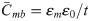
Electrophysiological changes in cellular physiology occur with increasing malignancy.A: The specific capacitance of the cell membrane (C¯mb=εmε0/t) increases with malignancy in the MOSE cell line, from the MOSE-E (n = 14), MOSE-L (n = 15), and MOSE-LTICν (n = 13). B: The specific conductance of the cell membrane (G¯mb=σmb/t) and C: the cytoplasmic conductivity (σcp) also increase with increasingly malignancy. D: The cell radius (R) decreases with increasing malignancy between the MOSE-E and MOSE-L cells, but shows little difference between the MOSE-L and MOSE-LTICν cells. Data are shown as mean ± standard deviation. * indicates p < 0.01, ** indicates p < 0.001, *** indicates p < 0.0001, and n. s. indicates no significant difference.